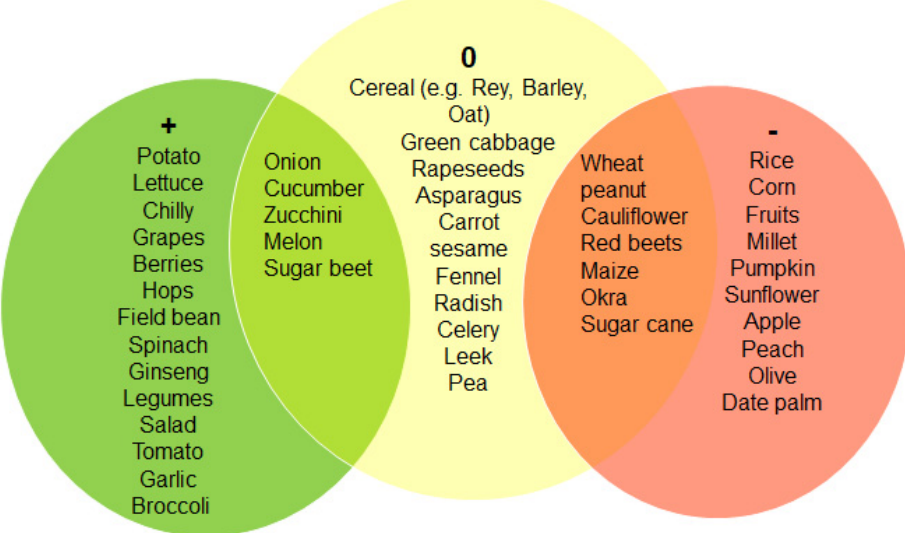
Figure 1. Suitable crops for solar dual-use (compiled from [1,3,10]). Crops that perform better with shading are put under the “+” category (green), whereas the shade-intolerant crops are under “ − ” (red). The crops under the “0” cat- egory are indifferent to shade when the overall crop yield is considered. Although this categorization gives a first overview of crops selection, it might not apply to all the locations around the globe. Field experiments are necessary to verify